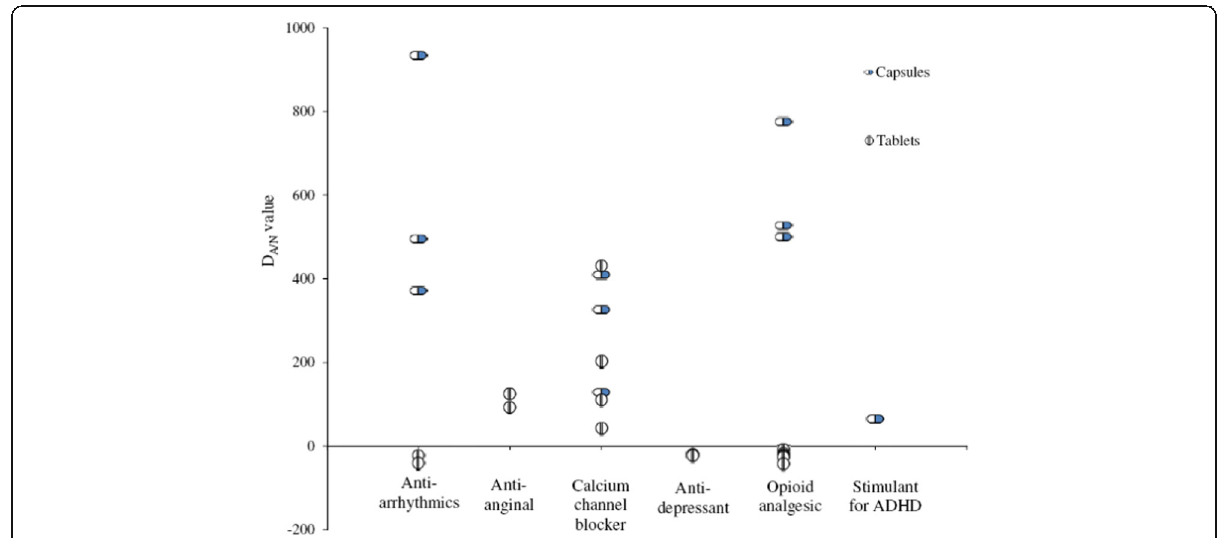
Fig. 4 D A/N values at 30 min in 40 and 20% alcoholic media (data from reference (Smith et al.